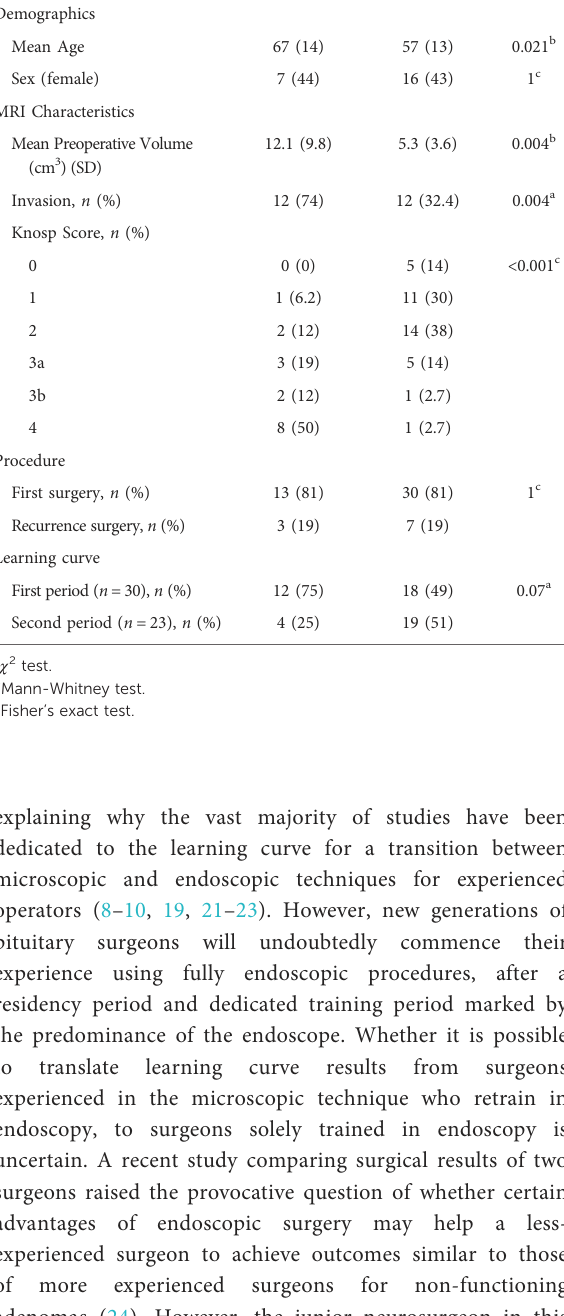
( Figure 3 ): every patient having NFPA with Knosp score <3 had GTR after the 30 fi rst patients operated and the mean volume of residual tumor was 0.6 cm 3 for the whole cohort.